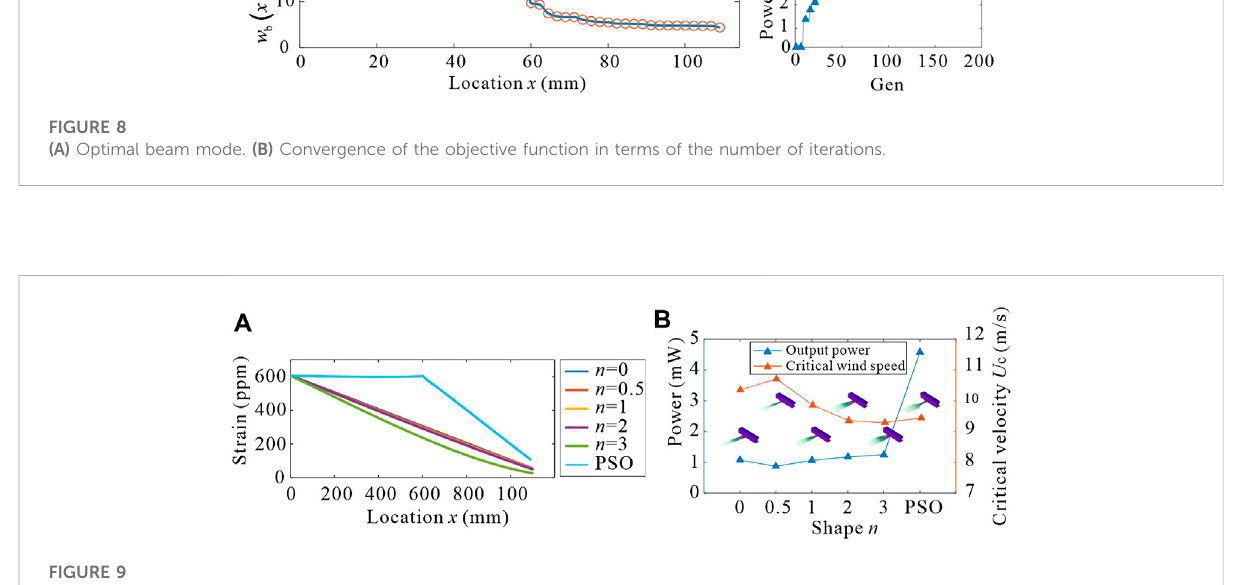
FIGURE 9 (A) Strainalongthelengthofpiezoelectriccantileverbeamswithdifferentshapes. (B) Outputpowerandcriticalvelocityofbeamswithdifferent